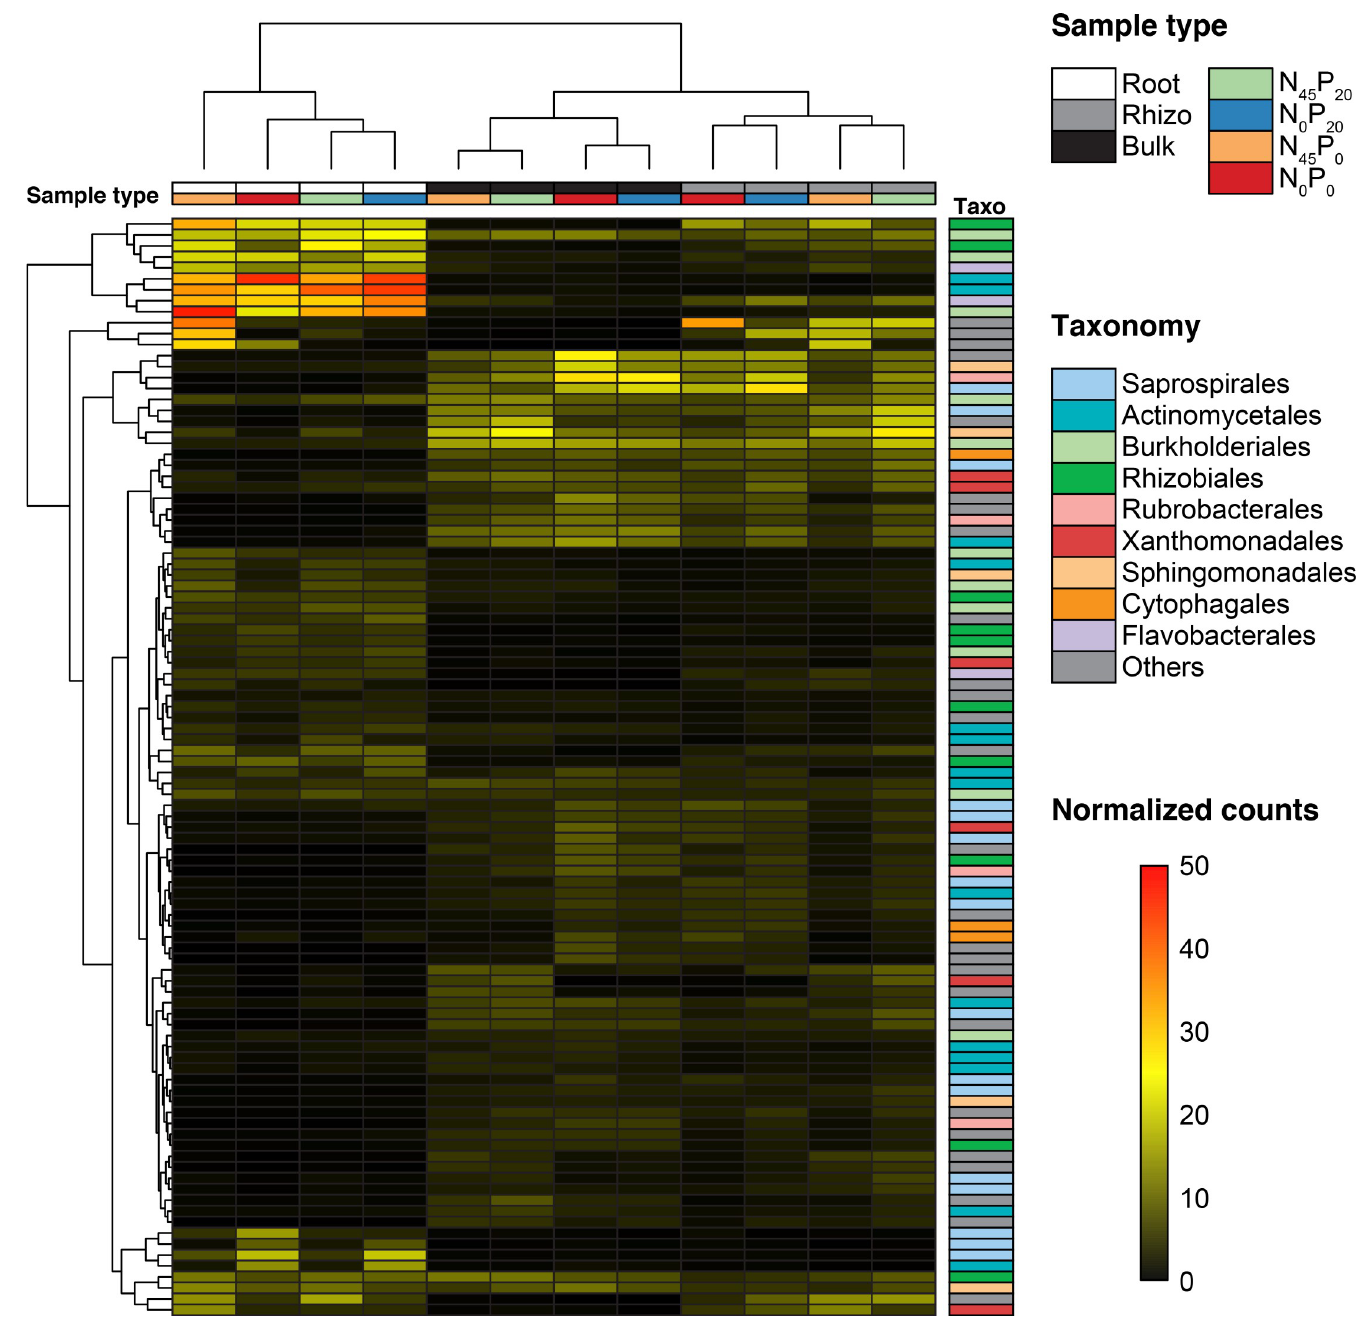
Fig 4. Dominant bacterial OTUs. The 100 OTUs that had the highest global average relative abundances in the 172 samples. Samples types (compartment and fertilization) are indicated with colored cells above the heatmap, and OTUs’ taxonomic affiliations are indicated at the order level right of the